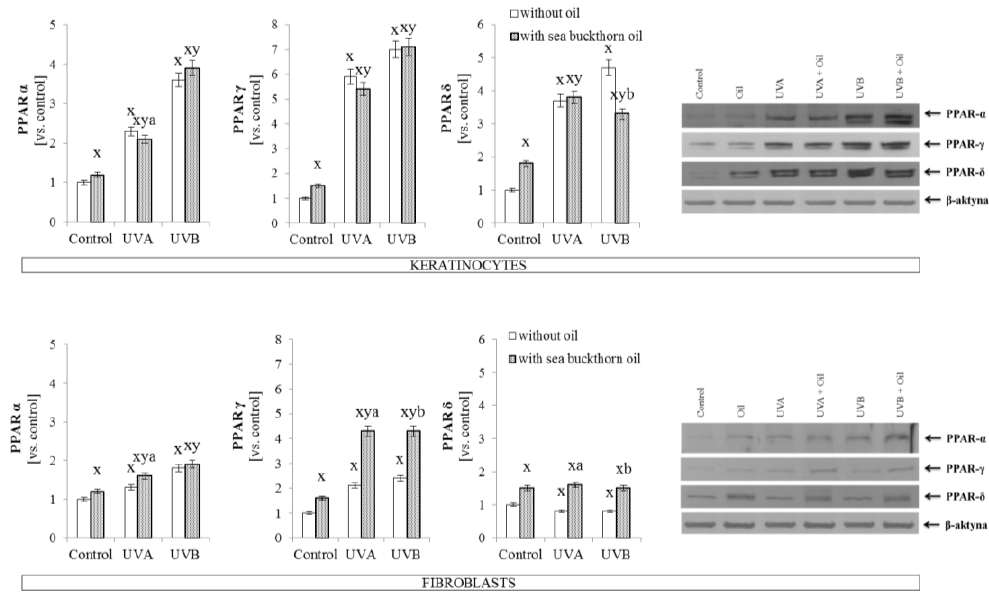
Figure 1. The expression of transcription factor phospho-Nrf2 (pSer40), its main target HO-1, and its inhibitor/activators-Keap1, p21, p62 in keratinocytes and fibroblasts after exposure to UVA (30 J/cm 2 and 20 J/cm 2 ) and UVB radiation (60 mJ/cm 2 and 200 mJ/cm 2 , respectively) and sea buckthorn seeds oil (500 ng/mL) treatment. Mean values ± SD of five independent experiments are presented. x statistically significant differences vs. control group, p < 0.05; y statistically significant differences between UVA/UVB and oil treated groups vs. oil treated control group, p < 0.05; a statistically significant differences between UVA and oil treated group vs. UVA treated group, p < 0.05; b statistically significant differences between UVB and oil treated group vs. UVB treated group, p < 0.05.